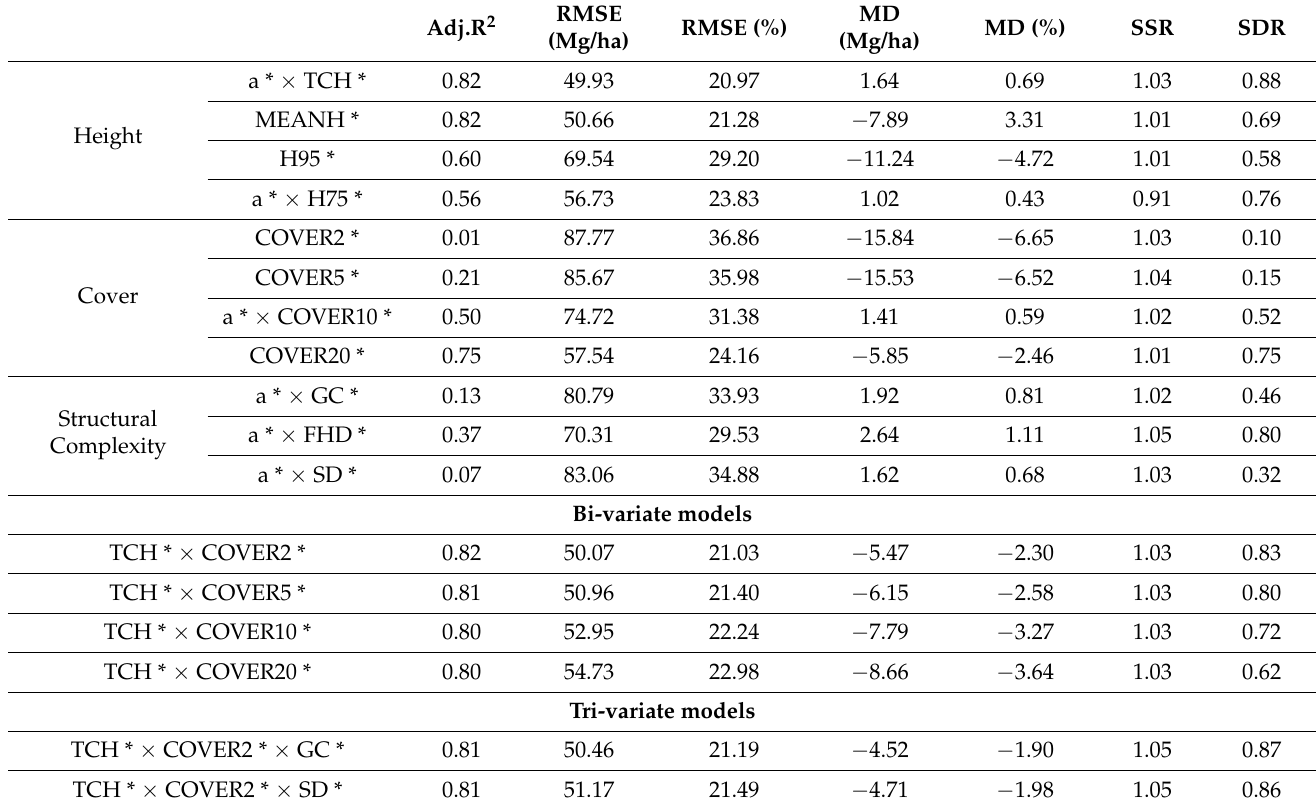
Table 2. Statistics reflecting accuracy and goodness of fit for AGB